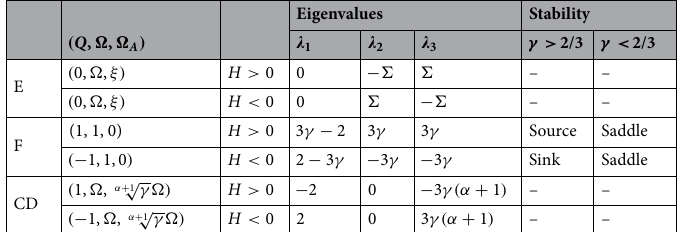
1 2 � α ) 1 and α 3 + −